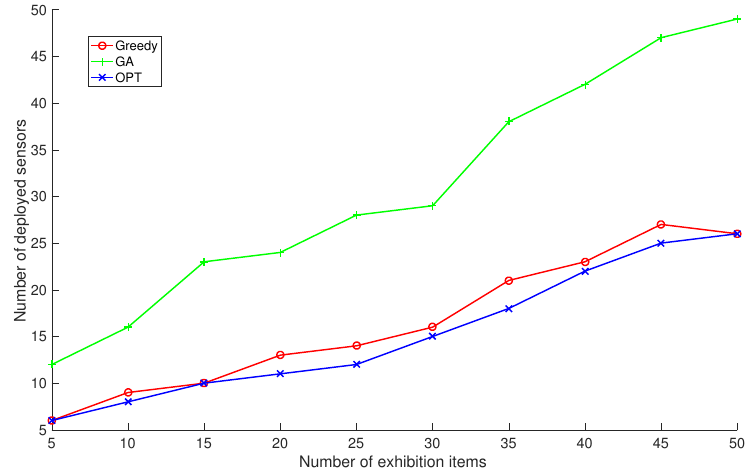
Figure 9. Performance comparison of GreedyDLDT (Greedy), Genetic Algorithm (GA), and Optimal Algorithm (OPT) for a museum exhibition hall with sensor mounting constraints in response to a varying number of exhibition